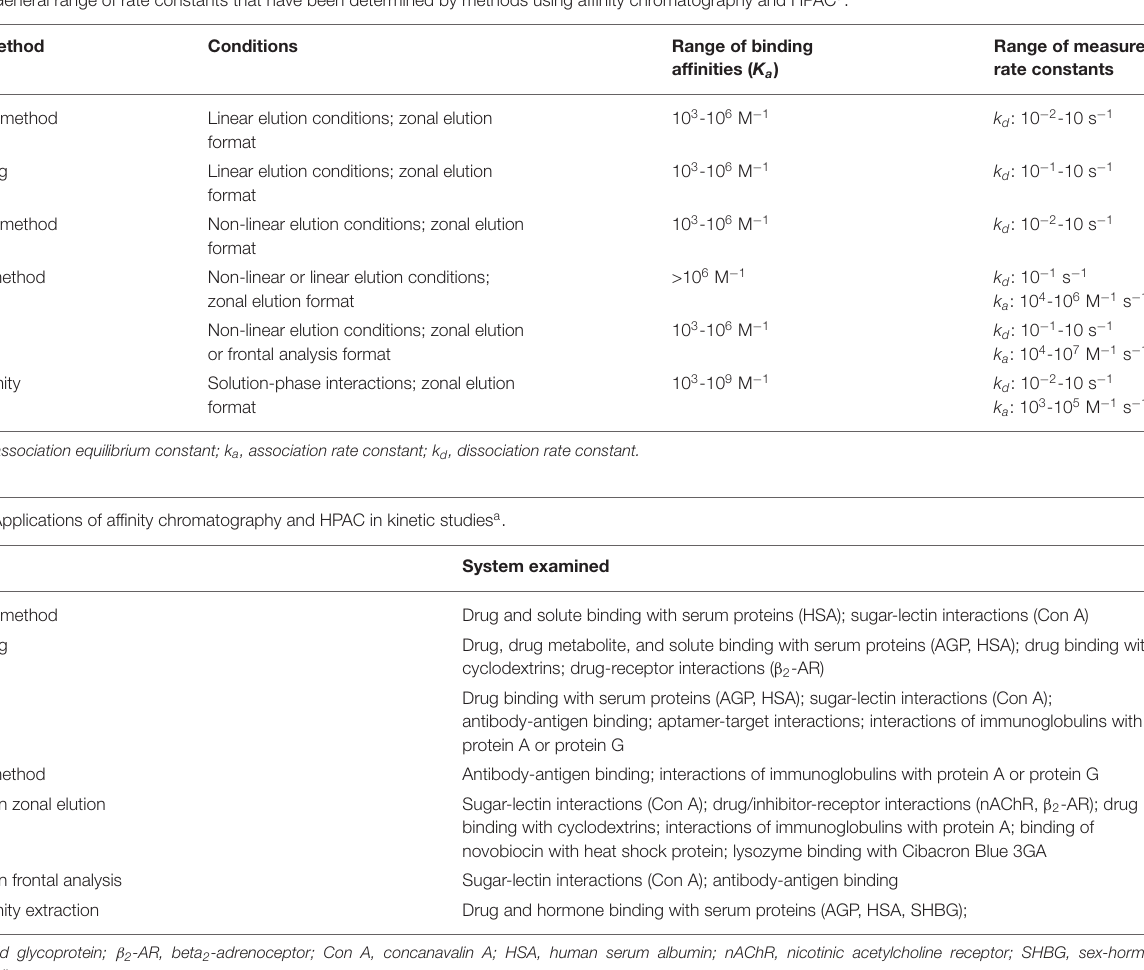
TABLE 1 | General range of rate constants that have been determined by methods using affinity chromatography and HPAC a .